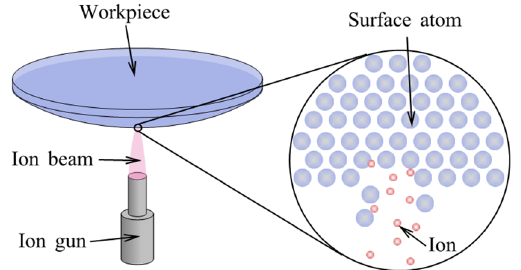
Figure 25. The schematic diagram of IBF [184].